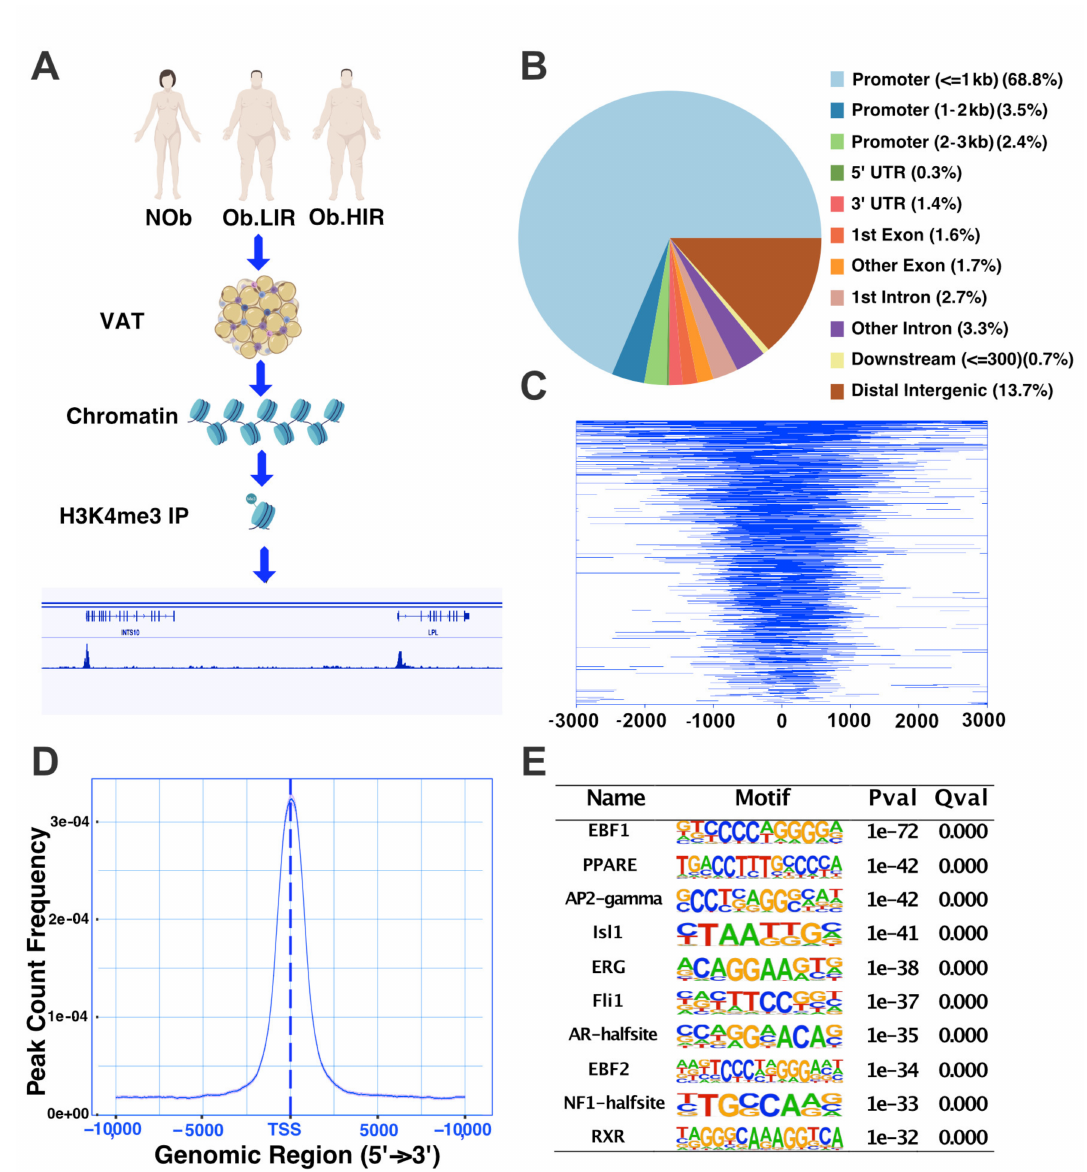
Figure 1. ( A ) Schematic workflow. In this study, VATsamples were collected from non-obese individuals (Nob) and obese subjects with either low and high insulin resistance (O.LIR and O.HIR, respectively). The samples were processed to extract the chromatin, which was immunoprecipitated (IP) using magnetic beads coated with H3K4me3 antibodies. The DNA from the IP chromatin was then purified and sequenced in order to obtain the H3K4me3 histone modification profile over the genome. Annotation of the H3K4me3 peaks found showed that most of the enrichment, nearly 75%, was located inside promoter regions ( B ). Enrichment feature distribution also showed a wide gene enrichment of H3K4me3 in adipose tissue located mainly between 1Kb up and downstream of transcription start sites (TSS) of the genes ( C ). As is shown in ( D ), most of the reads sequenced were concentrated around the TSS. ( E ) Top of enriched known motives present in H3K4me3 peaks in human